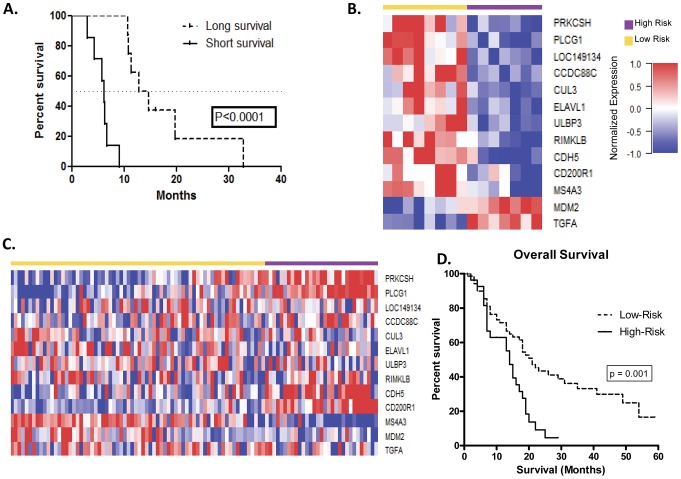
Application of a 13-gene prognostic signature for patients with PDAC.(A) Kaplan-Meier overall survival of patients comprising the UVA-15 derivation set grouped by short survival time (n = 7, survival range: 2.0–9.0 mo; median: 6.1 mo) and long survival time (n = 8, survival range: 10.6–32.8 mo; median: 13.7 mo; log-rank p<0.001). (B) Expression of 13-genes in the 15-tumor derivation set of patients with PDAC reveals clustering into high- (purple bar) and low-risk (yellow bar) populations. (C) Application of the 13-gene signature to an independent validation set of 101 patients with localized and resected PDAC reveals clustering into high- (purple bar) and low-risk (yellow bar) groups based on gene expression. (D) Kaplan-Meier overall survival of the independent validation set according to high- and low-risk groups as determined by 13-gene signature (log-rank p = 0.001).